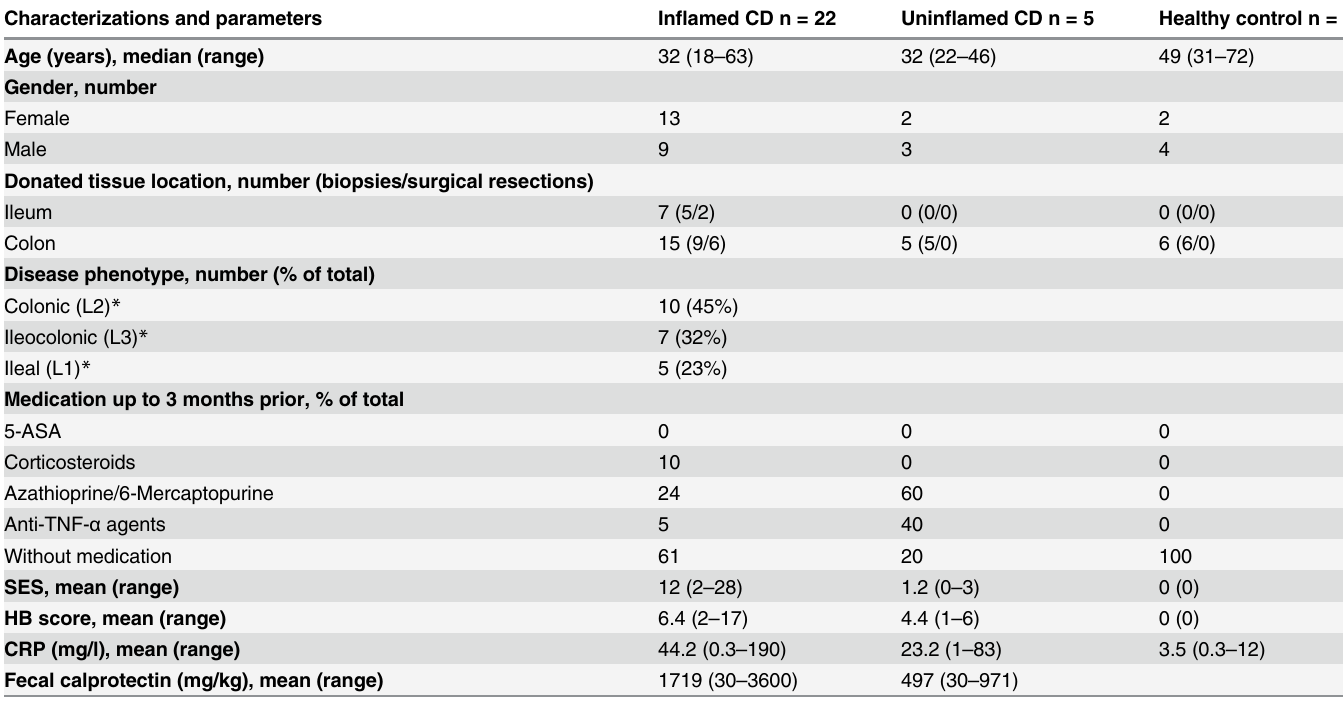
Table 1. Clinical features of patients and healthy